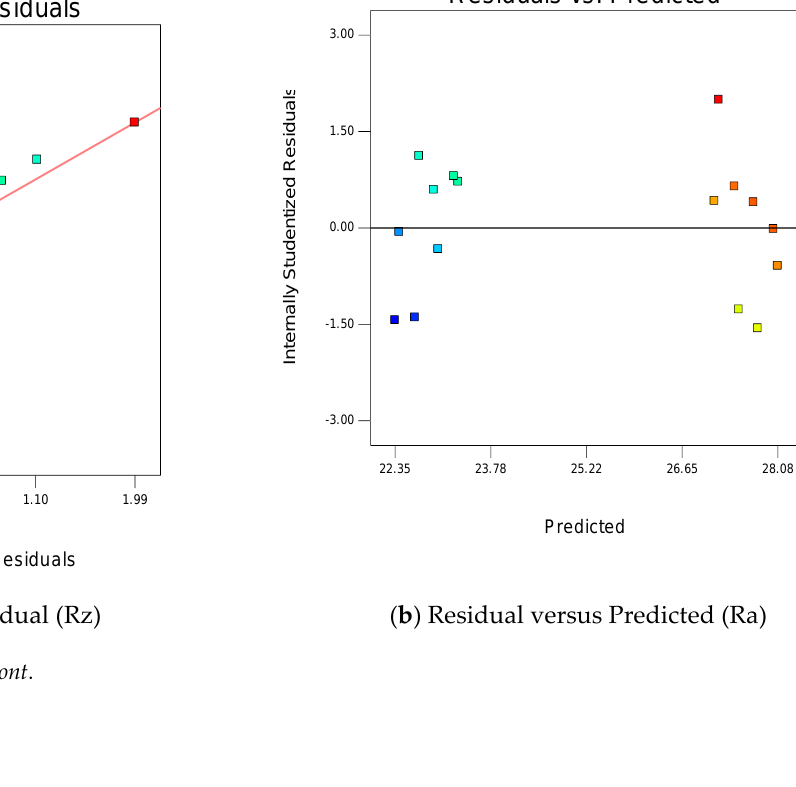
Figure 5a,b represents the normality test and residual versus predicted test for the verification of a good ANOVA. The residuals position in both plots are as per the signifi- cance of good ANOVA. The variations of Rz with Aon, Aoff, SV and WT are provided in Figure 5c. It is clear from Figure 5c that the value of Rz increases with increase in the Aon value. This is due to high discharge power, which increases the crater size and increases the Rz values [40]. It is observed from Figure 5c that amplification in Aoff values increases the Rz value. This is due to the fact that high Aoff values in the circuit diminish the discharge power; then the crater sizes on the surface decrease and hence Rz values. The increase in SV increases the Rz value, which is due to increase in the IEG by increasing the SV value and enhancing the Rz value. Thus, a low value of SV favors the surface quality [30]. A high value of WT also increases the surface quality by eliminating the deflections from the wire electrodes. Equation (17) gives the empirical relation between Rz and input parameters of WEDM.